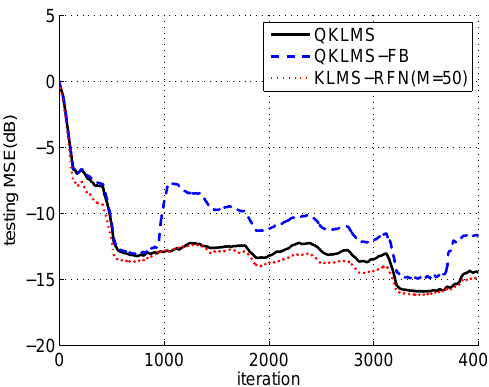
Figure 4. The testing MSE curves of the KLMS-RFN, quantization criterion-based kernel least mean square (QKLMS), and fixed-budget quantized kernel least mean square (QKLMS-FB) algorithms for Lorenz time series prediction.